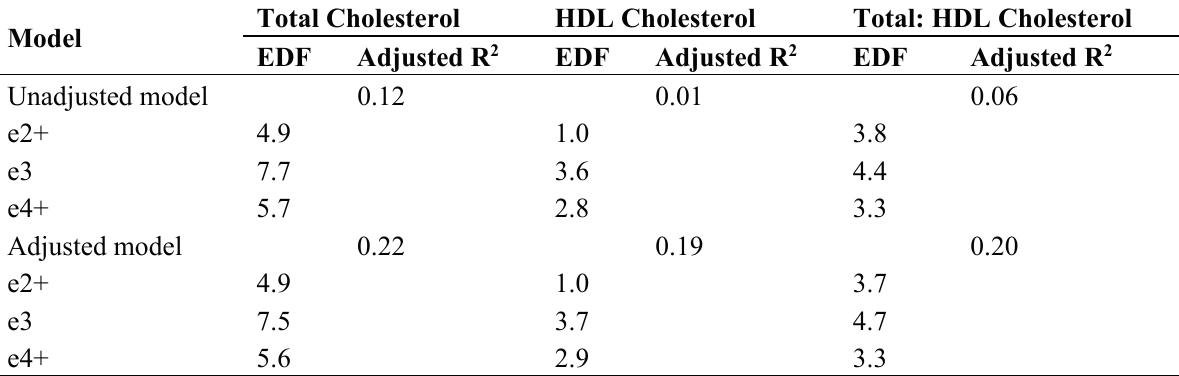
Table 3. EDF and adjusted R2 for trajectories of total, HDL, and total: HDL cholesterol ratio stratified according to APOE allele